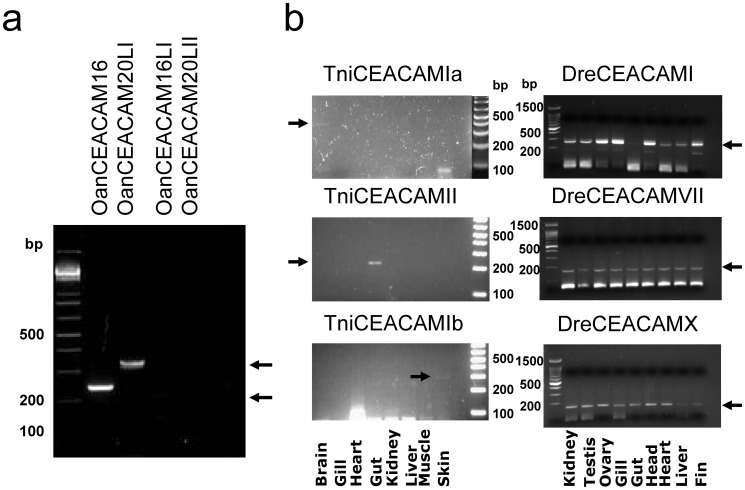
Analysis of CEACAM transcript expression in tissues of platypus, pufferfish T. nigroviridis, and zebrafish D. rerio.
a) RT-PCR analysis of OanCEACAM16, 16LI, 20LI, and 20LII in the intestine of a platypus. Size markers are shown on the left. Specific PCR products for OanCEACAM16 and 20LI are indicated by arrows. b) RT-PCR detection of transcripts of DreCEACAMI, VII, and X in kidney, testis, ovary, gill, gut, head, heart, liver, and fin of D. rerio (right panel) as well as TniCEACAMI-III in brain, muscle, gut, kidney, heart, liver, gill, and skin of T. nigroviridis (left panel) using gene-specific primers (Table S4 in File S1). Expected size of PCR products for each gene is indicated by an arrow.